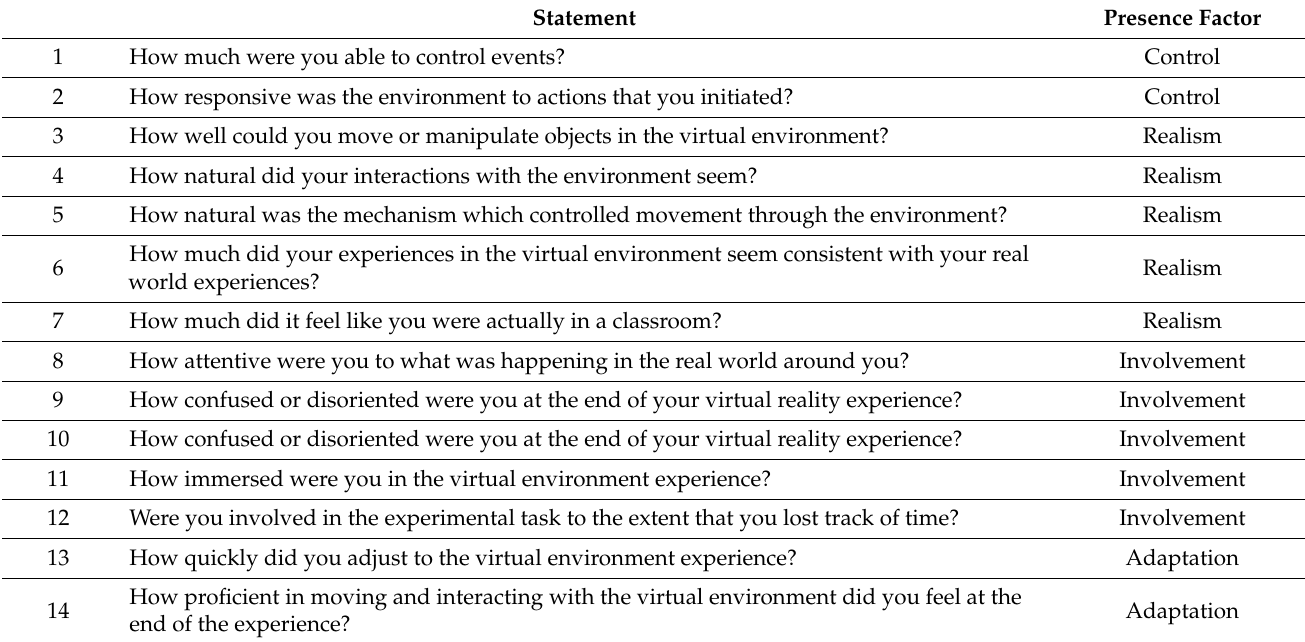
Table A1. Presence questionnaire statements (seven-point scale) adapted from Witmer and Singer [27].